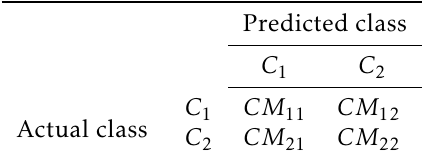
Table 1. An example confusion matrix with two